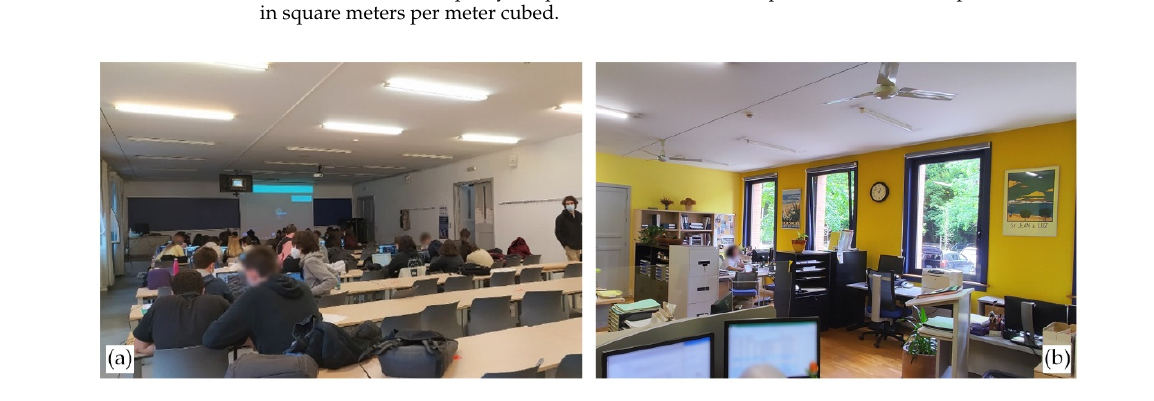
Figure 8. Image ( a ) shows a lesson held in classroom A 1.1 during the winter of 2020–2021, with windows and doors open for cross ventilation. Image ( b ) on the right offers a typical view of